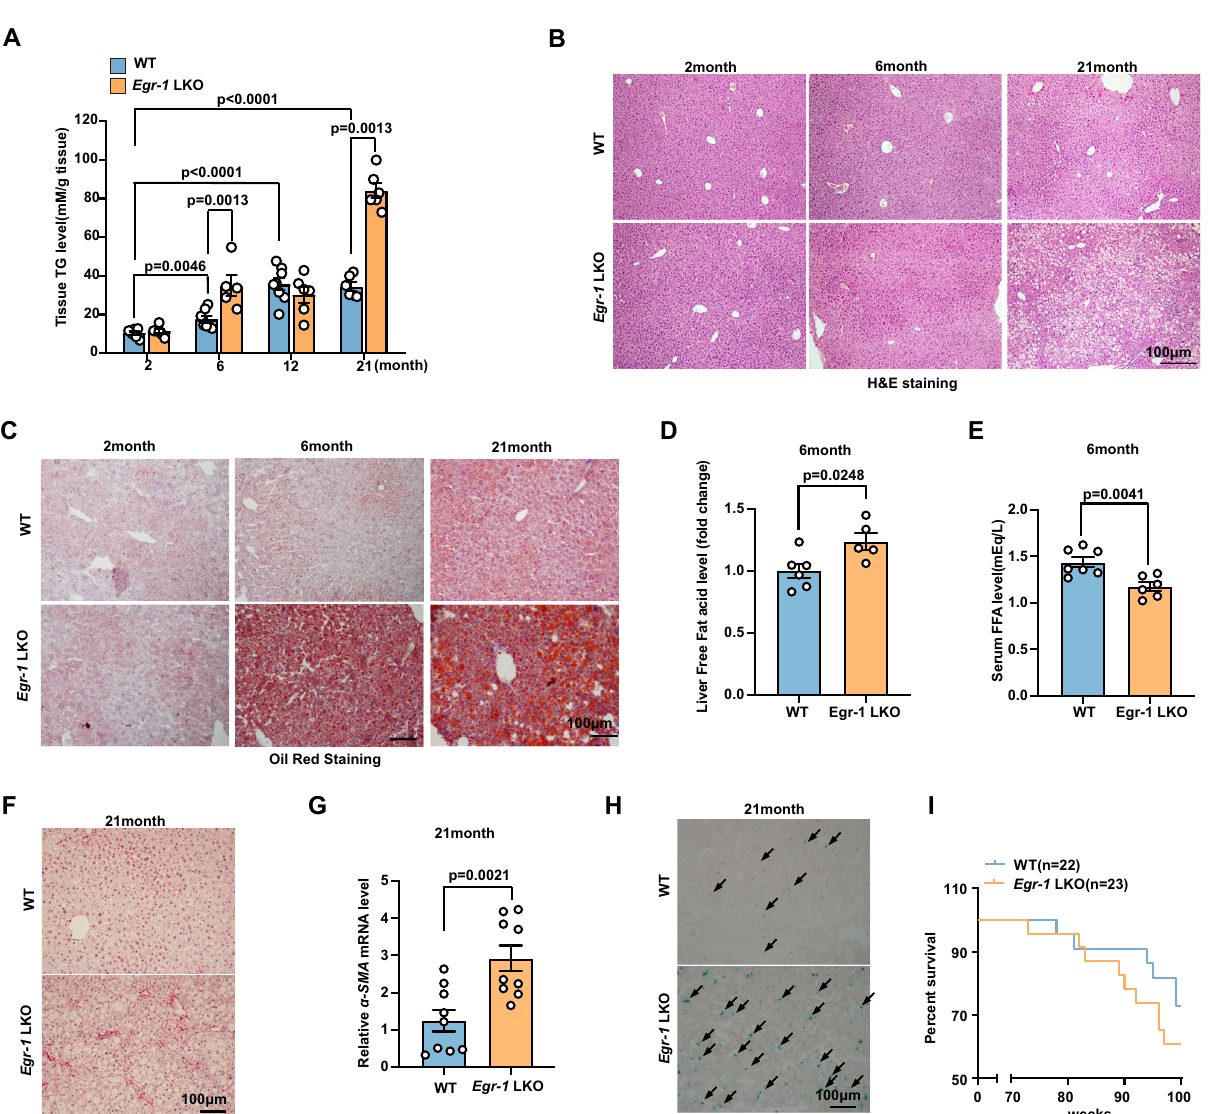
Fig.2|ThephaseoftheEgr-1circadianrhythminthelivermovesforwardwith aging. A Heatmap represents rhythmic clock and clock-controlled genes exclu- sivelyintheliversofC57BL/6miceat2months,6months,and12months; B mRNA expression of Egr-1 at the indicated time points in the livers of C57BL/6J mice at 2 months, 6 months, and 12 months (2 month ZT1: n =4, ZT5,9,21: n =5, ZT13,17: n =6; 6 month ZT1,9: n =5, ZT5,13: n =4, ZT17,21: n =6; 12 month: n =5 biologically independent animals), black dot means the peak expression of Egr-1 pointateachgroup. C – E Proteinexpressionof Egr-1 at theindicated timepointsin theliversofC57BL/6Jmiceat2months,6months,and12months( n =5biologically independent animals in 2 months; n =3 biologically independent animals in